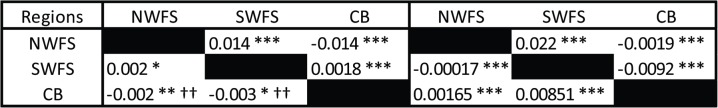
Pairwise measures of genetic differentiation among gag populations in the Gulf of Mexico.Left section of table shows standardized measures of genetic differentiation (φ’ST) of microsatellite markers below the diagonal and φST-values of all mtDNA data (sequence and indel repeats) above the diagonal. Right section of table shows φST-values for sequence data only and φST-values for mtDNA indel repeats above the diagonal. “*” denotes population significantly different using exact test; “†” denotes populations significantly different using χ2-test. Number of each respective symbol indicates level of significant (e.g. * is p < 0.5; ** and †† are p < 0.01; *** is p < 0.001).